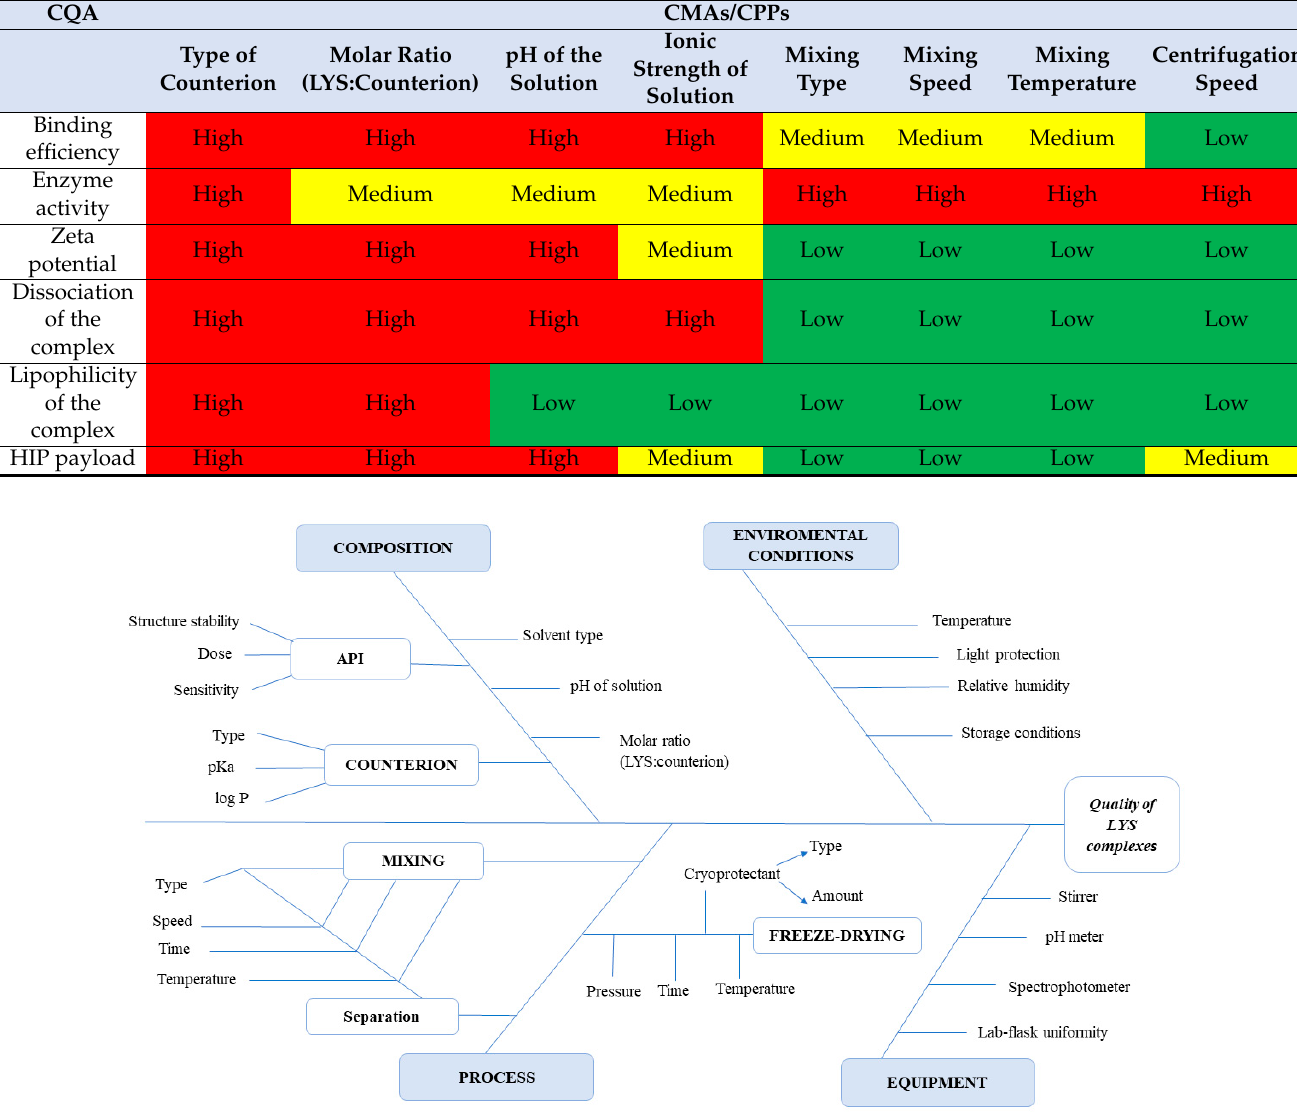
Figure 1. Ishikawa quality diagram of LYS HIP complex.